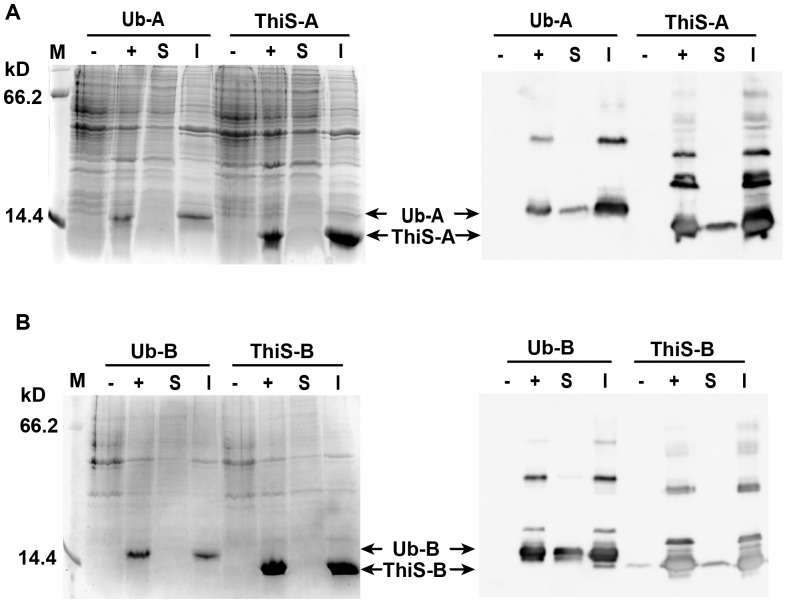
Expression of insulin chains with ThiS or Ubiquitin fusion?Insulin A chain (A) or B chain (B) fused with ubiquitin (Ub) or ThiS, were expressed in E. coli BL21 (DE3) pLysS. Total cell lysate from uninduced (−) or induced (+) cells with IPTG, and the soluble (S) or insoluble fraction (I) of induced cells were electrophoresed on 15% SDS-PAGE, shown in left panels. Marker proteins are shown in lane M with sizes at left. Expressed proteins were verified by Western blot probed with anti His-tag antibody, shown in right panels. Arrows highlight expressed proteins at expected positions.